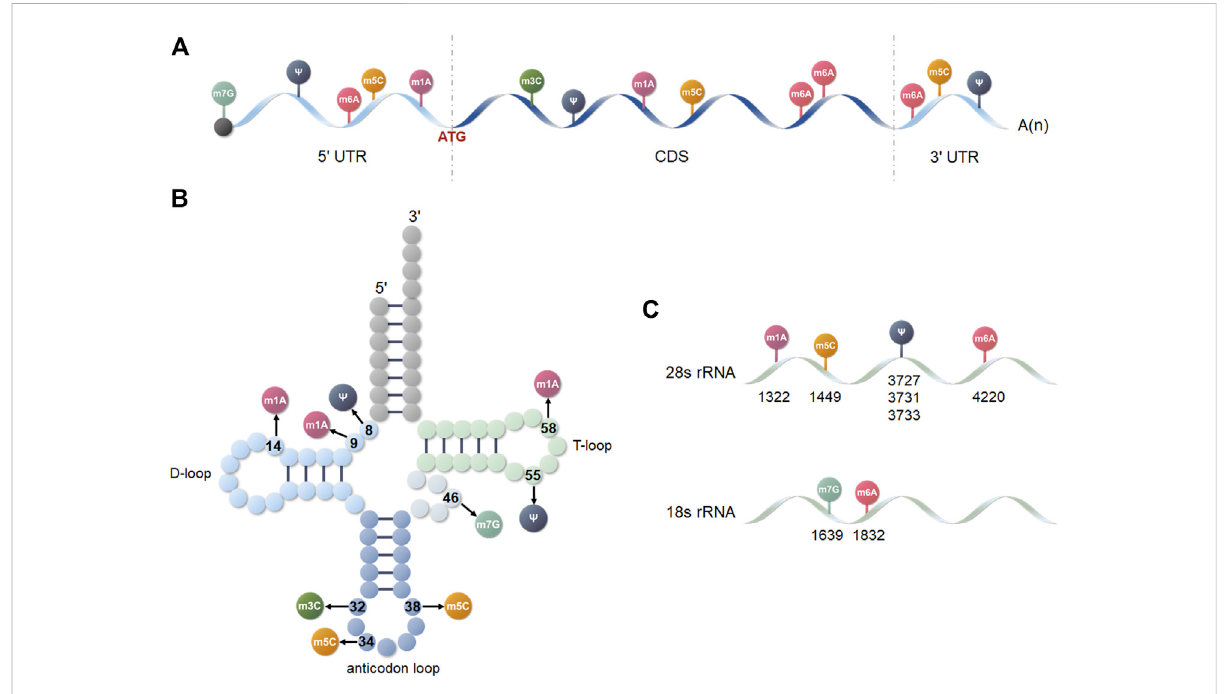
Distribution of the six posttranscriptional modi fi cations on different RNA isoforms. (A) mRNA. (B) tRNA. (C) 18 and 28s